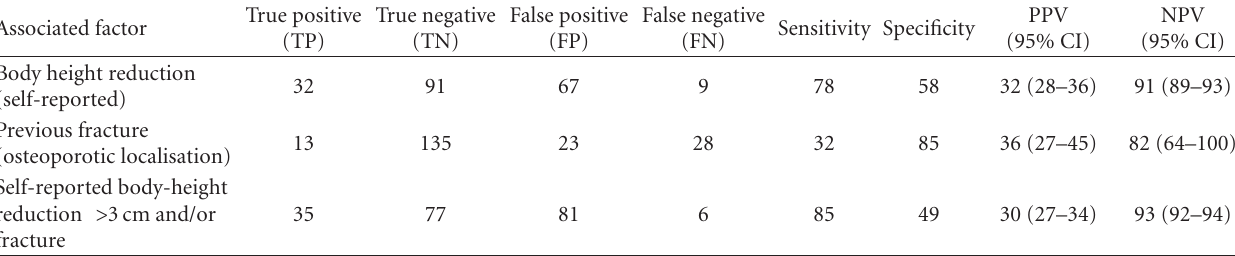
Table 3: The ability of two selected factors to correctly identify fallers with osteoporosis. Sensitivity, specificity, positive predictive values (PPVs), and negative predictive values